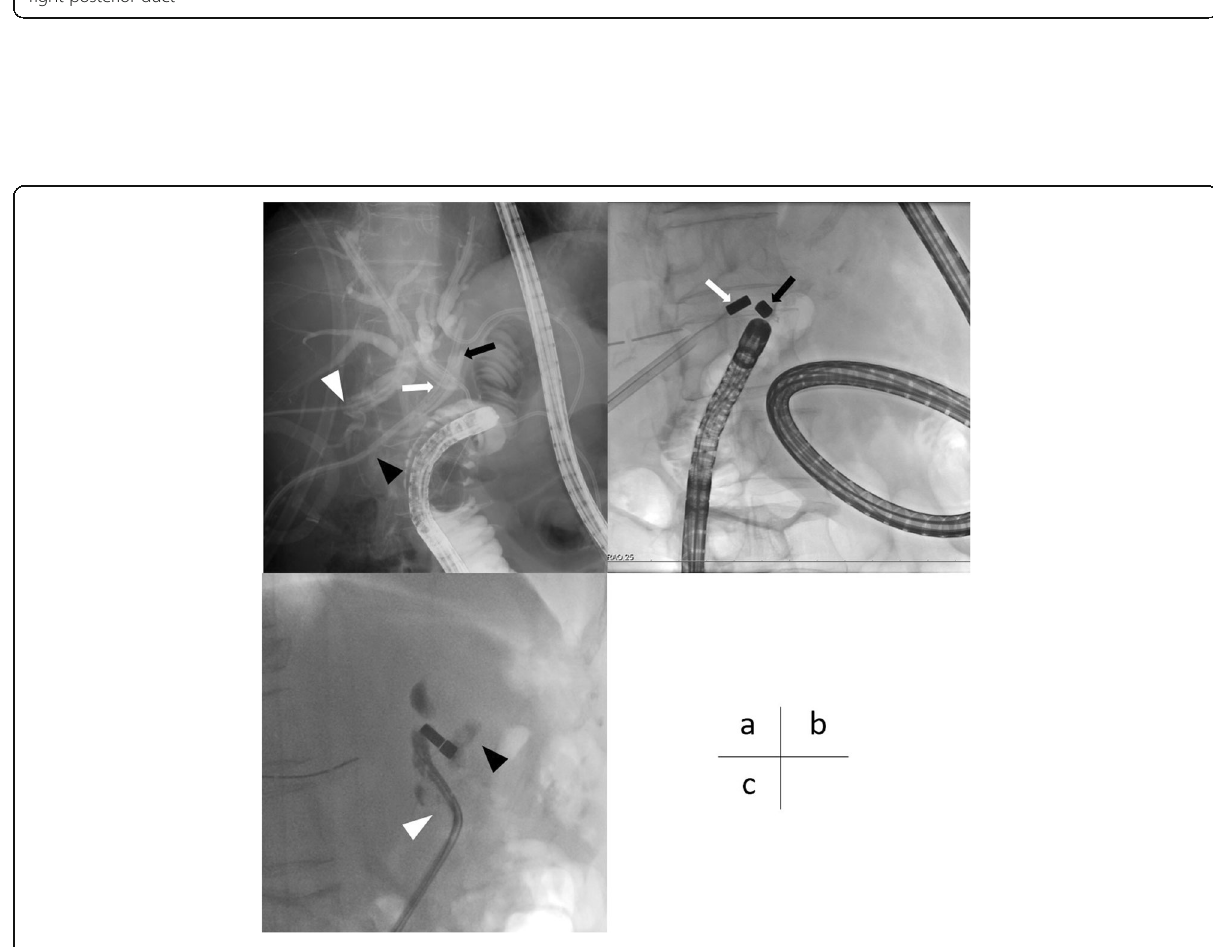
Fig. 2 a We checked that the stumps of the RAD (black arrow) and RPD (white arrow) were near the bowel for MCA by contrast radiography. We placed PTCD tubes in the RAD (black arrowhead) and RPD (white arrowhead). b MCA for the RAD was performed. The magnet (black arrow) was introduced into the bowel near the RAD by double-balloon endoscopy, and another magnet (white arrow) was inserted through PTCD of the RAD. c We confirmed the outflow of the contrast agent into the bowel (black arrowhead) via the PTCD tube placed in the RAD (white arrowhead). The bilioenteric fistula of the RAD was completed 21 days after MCA. MCA magnetic compression anastomosis, RAD right anterior duct, RPD right posterior